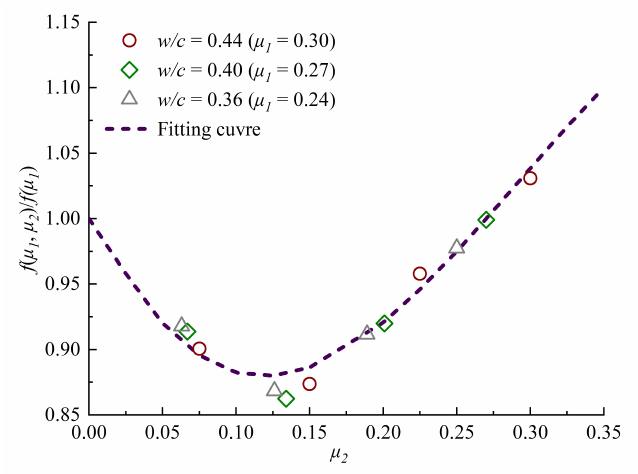
Figure 9. Relationship between f ( µ 1 , µ 2 ) / f ( µ 1 ) and µ 2